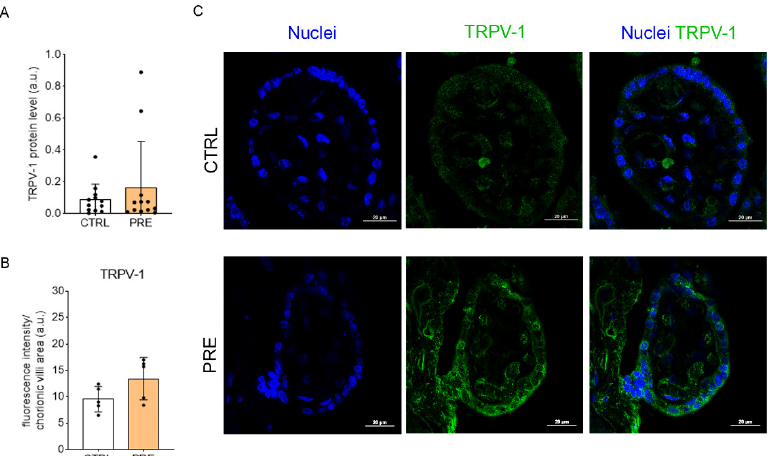
Figure 2. Relative levels of TRPV-1 in the two experimental groups. ( A ): Analysis of the TRPV-1 levels in placenta slices by western blot. Bars represent the densitometric analysis of TRPV-1 (100 kDa)/ β -actin (42 kDa) ratio ± SD of twelve independent replicates ( n = 12). ( B ): Analysis of the CB1 levels in chorionic villi by immunohistochemistry. Bars represent the fluorescence intensity per area of chorionic villi ± SD of five independent samples ( n = 5). In confocal images ( C ), nuclei are marked with DAPI (blue) and TRPV-1 is marked in green (Alexa Fluor ® 488); scale bar = 20 µm.